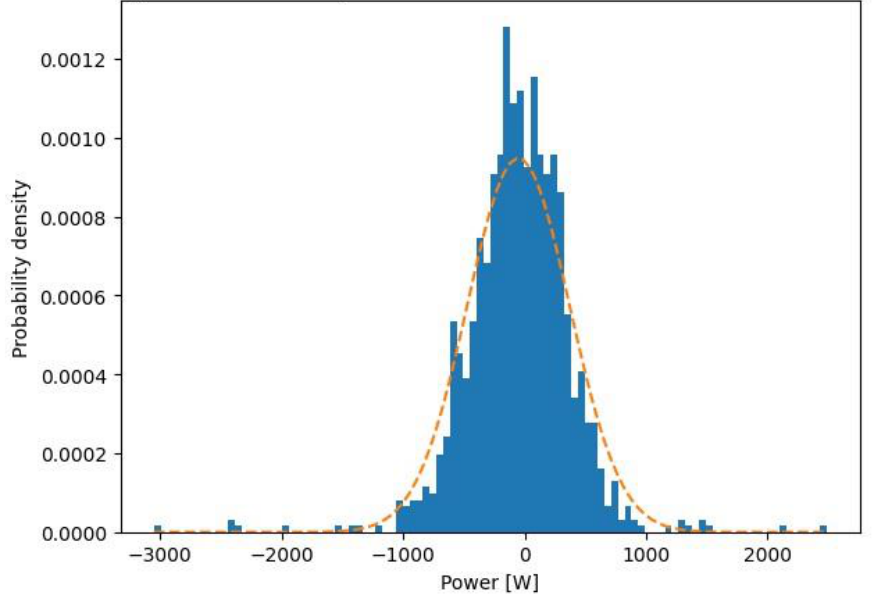
Figure 12. Histogram of residuals showing the probability density distribution of residuals resulting from the validation process of V-MLP-12.